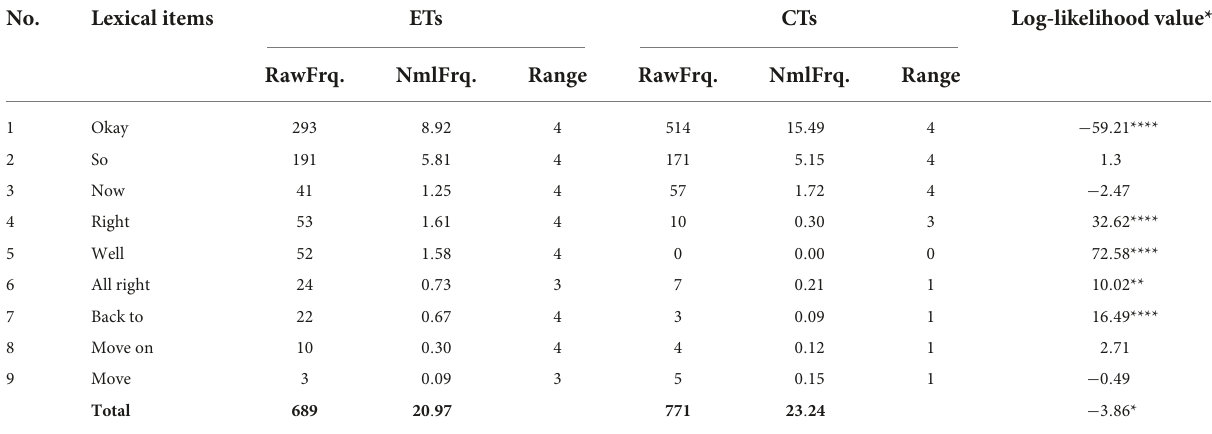
TABLE 9 Summary of shifting topics in both